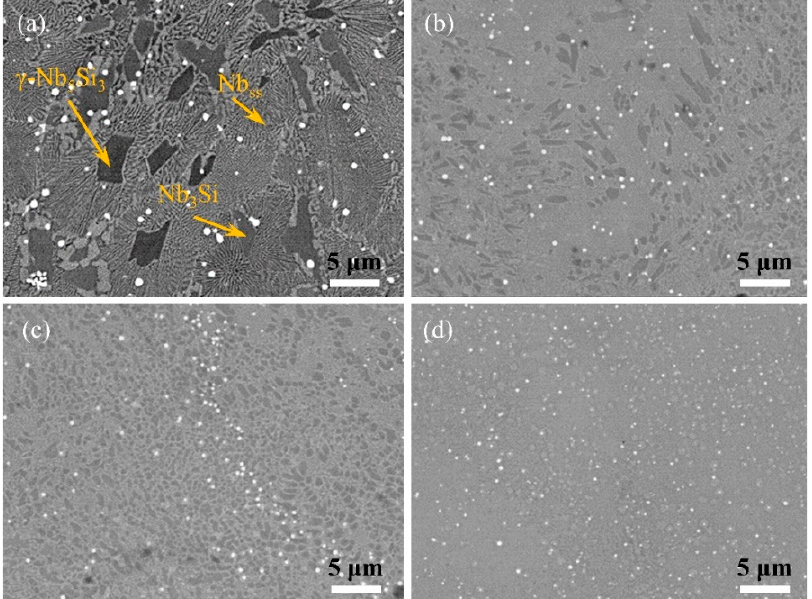
Figure 3. BSE pictures of the microstructure of Nb-18Si-5HfC-based alloys deposited at various scanning speeds: ( a ) 600 mm/s, ( b ) 800 mm/s, ( c ) 1000 mm/s, ( d ) 1200 mm/s.